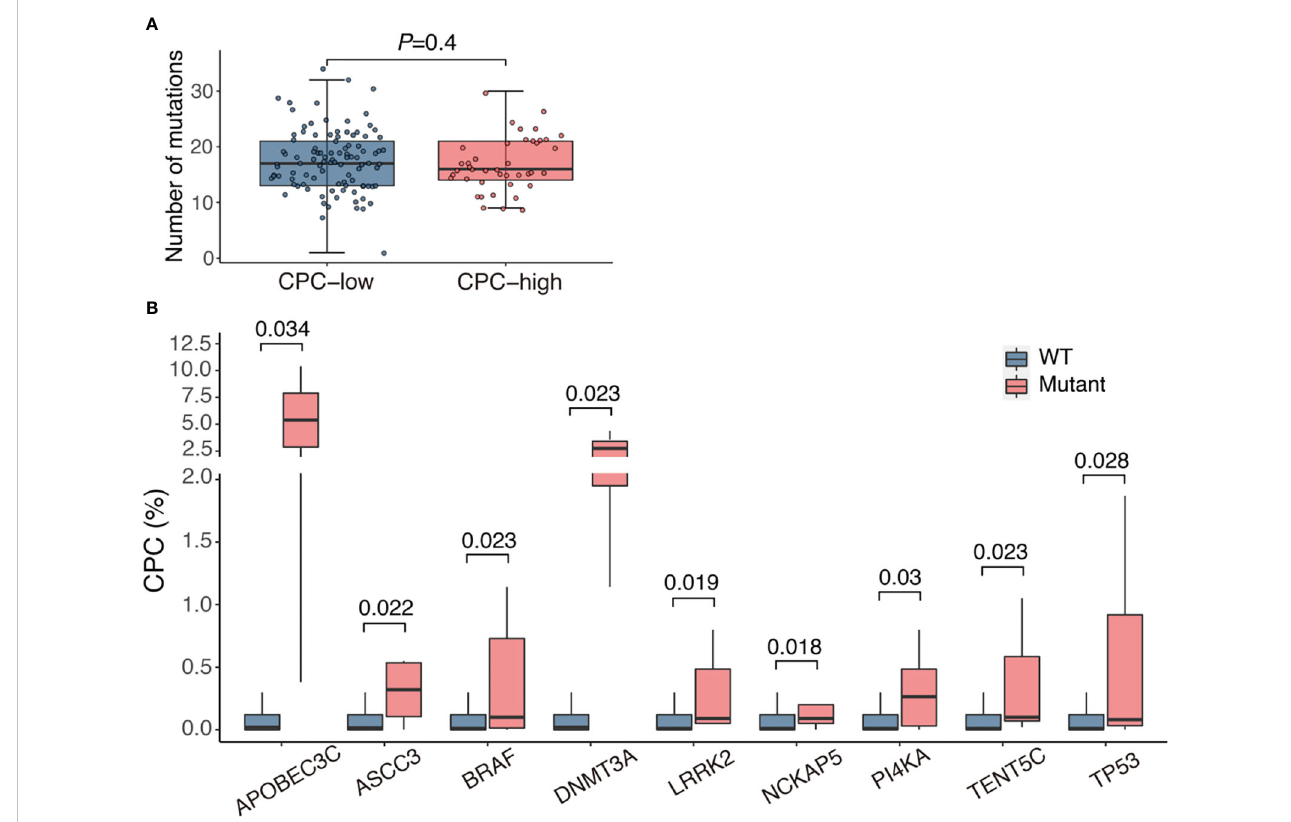
signaling pathways (Figure